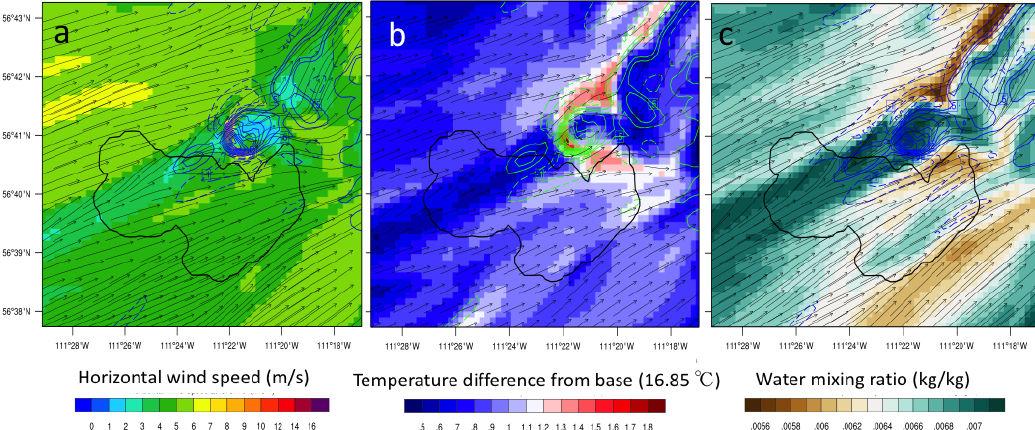
Figure 9. Horizontal snap shot at model level 10 (3000–3500 m above ground) on May 3, 2016 00 UTC of ( a ) wind speed and direction, ( b ) temperature gradient and wind direction and ( c ) mixing ratio and wind direction. The blue contour lines represent the vertical velocities. The dashed contours represent downdrafts, and solid line contours represent updrafts. The black line illustrates the fire